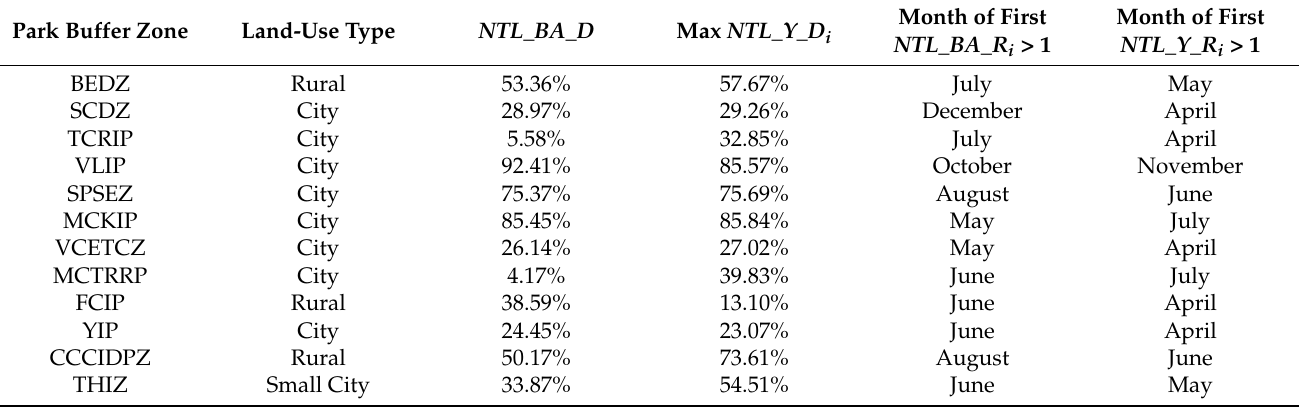
Table 5. Analysis of COVID-19 impacts on 10 km buffer zones around parks, according to the four ratio